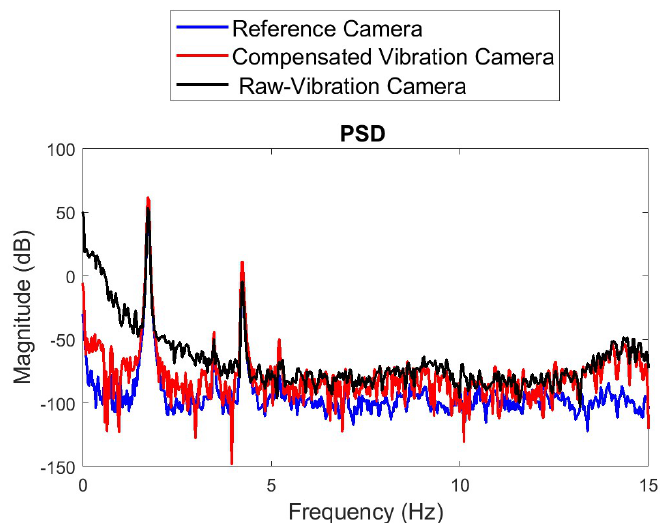
Figure 15. Comparison of estimated and reference second-story displacement in frequency domain.